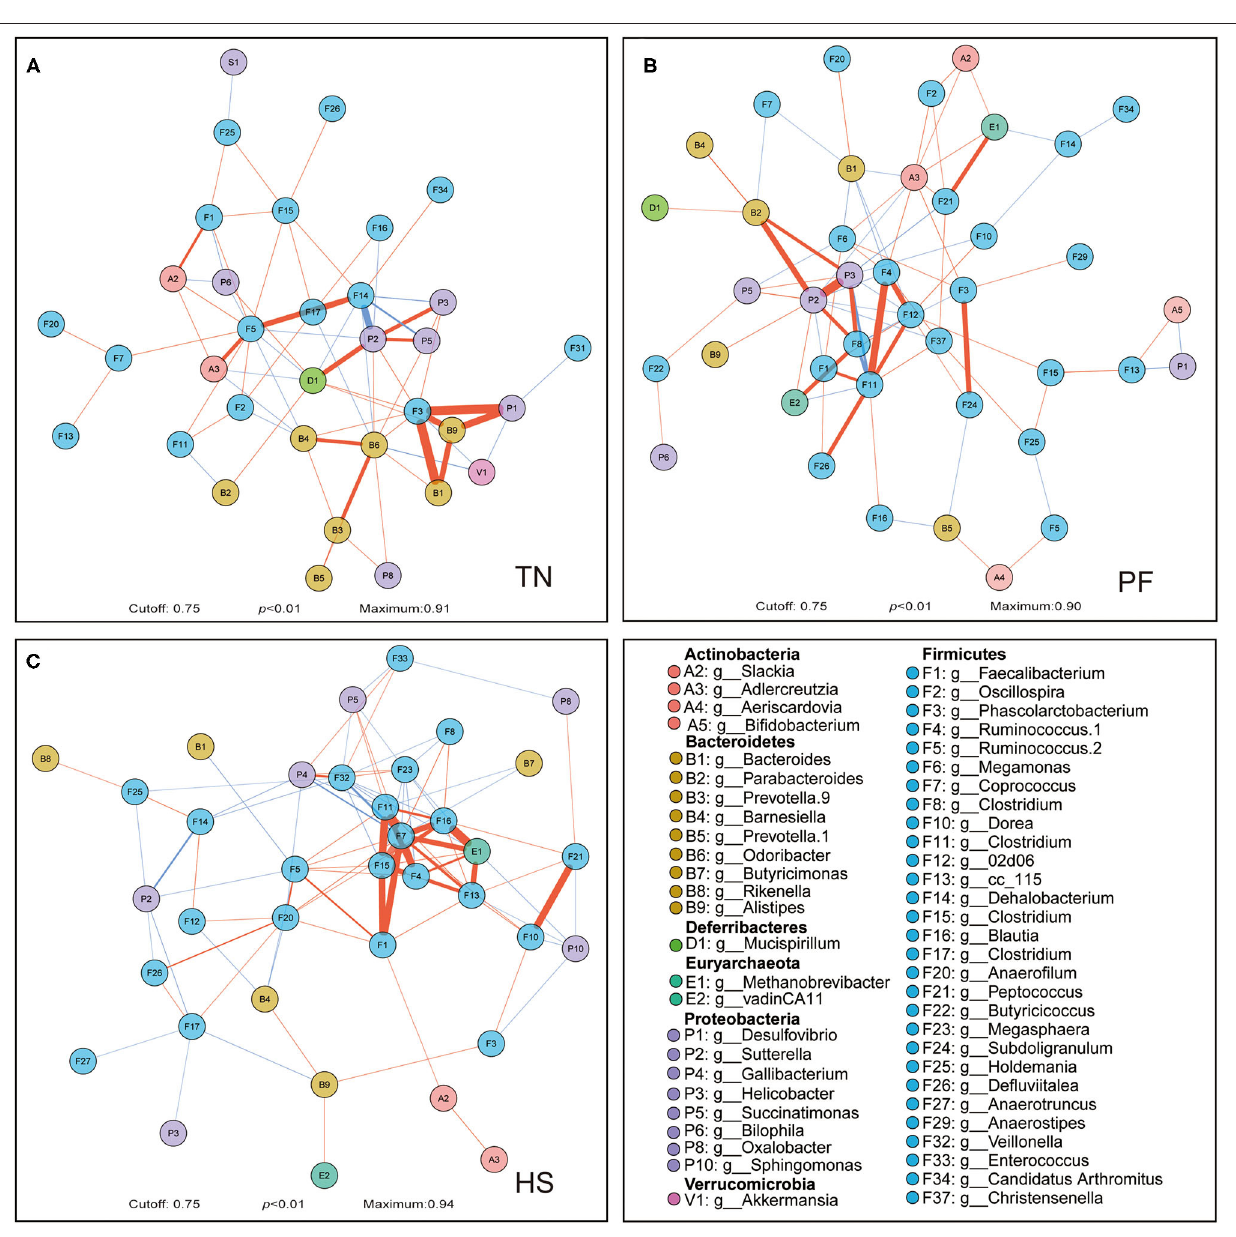
FIGURE 4 | Correlation networks observed between genera. Correlations between microbial genera among TN (A) , PF (B) , and HS (C) groups were calculated with the Sparse Correlations for Compositional data algorithm (SparCC). The different colors of the nodes represent different phylum, which the genera belonging. The edge color represents positive (red) and negative (blue) correlations, and the width of the edge represents the magnitude of the correlation (wider if it is higher). Only high-confidence interactions with pseudo p -value ≤ 0.01 were drawn in the network using the R package qgraph.